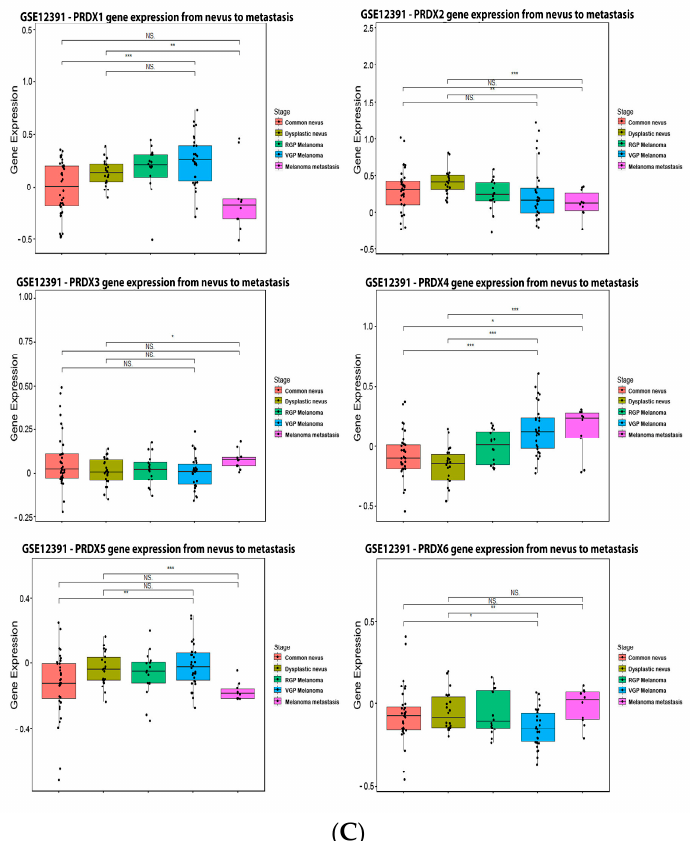
Figure 7. Peroxiredoxins on melanoma. ( A ) Percentage of patients with altered genes and types of genetic alterations; ( B ) overall patient survival status, and ( C ) expression in melanoma progression. Red boxes represent the common nevus, yellow boxes the dysplastic nevus, green boxes the radial growth phase (RGP) melanoma, blue boxes the vertical growth phase (VGP) melanoma, and purple boxes the metastatic melanoma. The statistical analysis was performed by ANOVA followed by Tukey test, *** p < 0.001, ** p < 0.01, * p < 0.05 when compared to common or dysplastic nevus. NS: Not